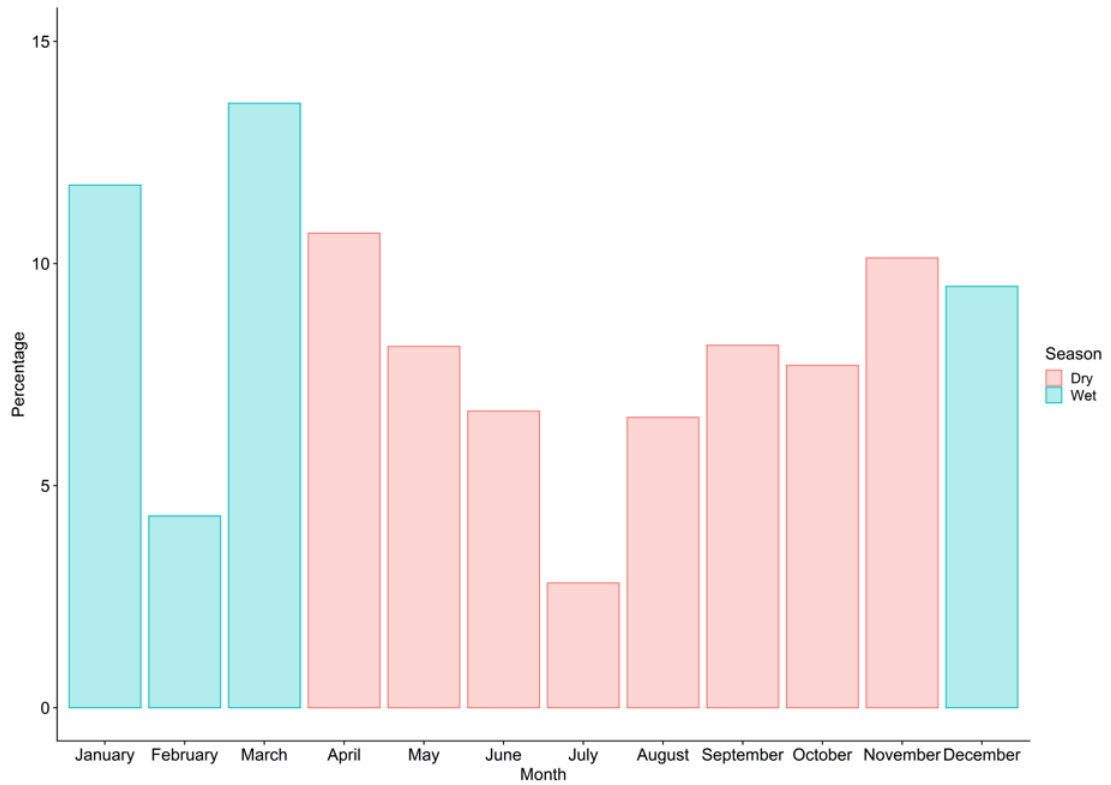
Figure 2. Catches of sharks by the artisanal fishing fleet in Manta from January to December